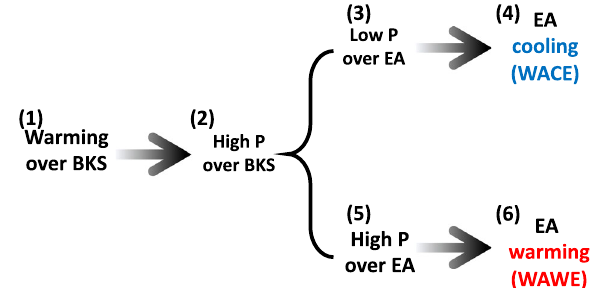
Fig. 4 Causality fl ow chart of the Arctic-midlatitude teleconnec- tion. Flow of the Arctic-midlatitude teleconnection that explains cold and warm continent patterns under Arctic